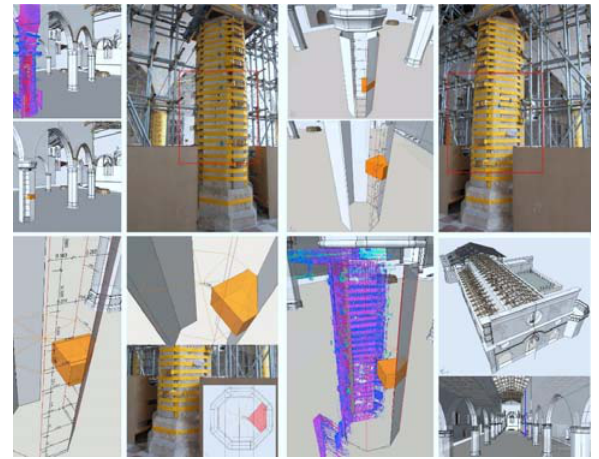
Figure 6. HBIM model from laser scanner data.